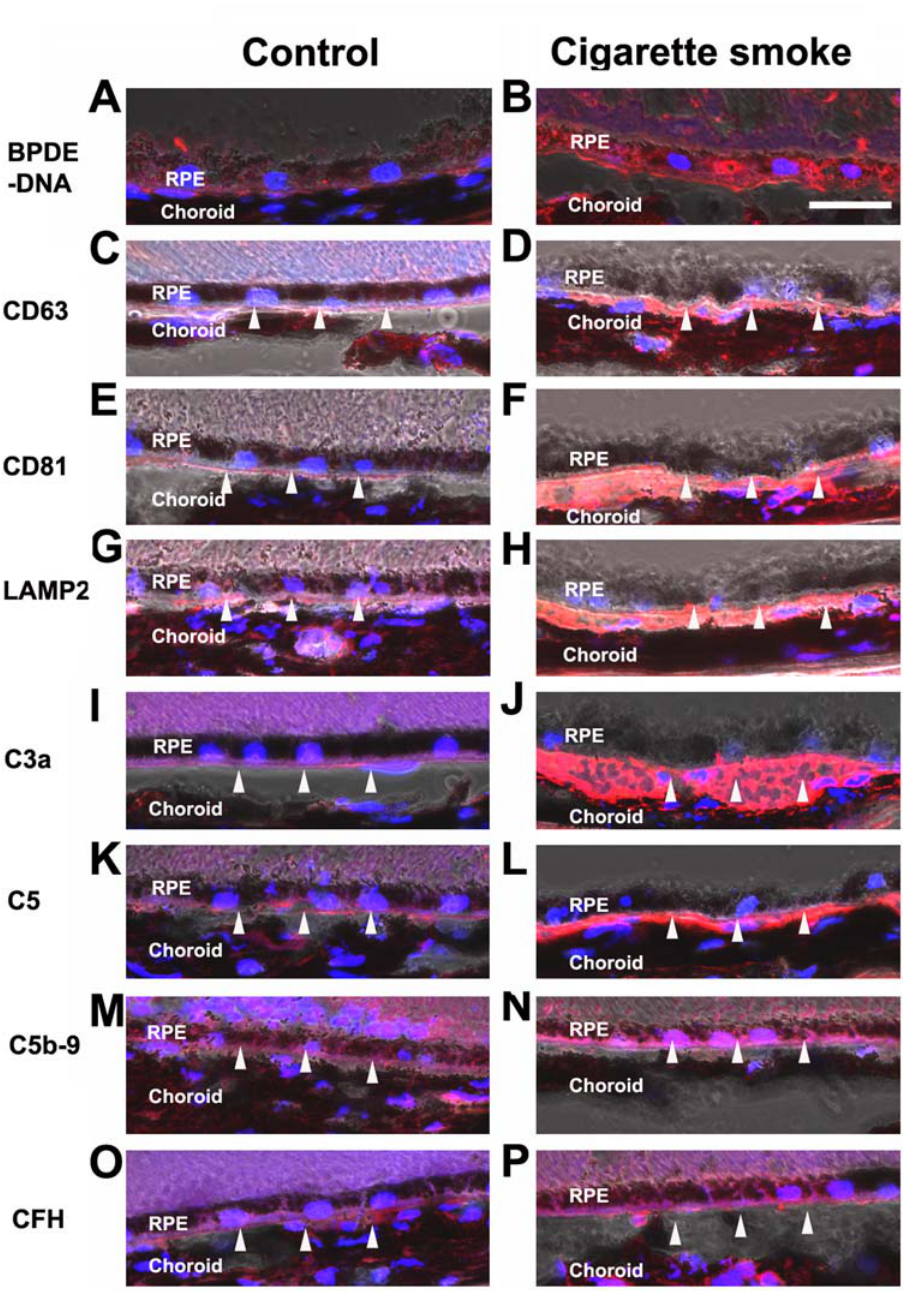
Figure 6. Immunolocalization of BPDE-DNA, exosome markers and complement pathway components in mice exposed to chronic cigarette smoke. These confocal immunofluorescence images were overlayed with the bright field images. (A–B) BPDE-DNA. Immunoreactivity to the BPDE-DNA adduct is present in RPE of mice exposed to chronic cigarette smoke ( B ), but not in control tissues ( A ). ( C–D ) CD63, Immunoreactivity to CD63 is observed in the area of Bruch’s membrane of mice exposed to chronic cigarette smoke ( D ), but not in the control tissues ( C ). ( E–F ): CD81. Immunoreactivity to CD81 is observed in the area of Bruch’s membrane of mice exposed to chronic cigarette smoke ( F ), but not in the control tissues ( E ). ( G–H ) LAMP2. Immunoreactivity to LAMP2 is observed in the area of Bruch’s membrane of mice exposed to chronic cigarette smoke ( H ), but not in the control tissues ( G ). ( I–J ) C3a. Immunoreactivity to C3a is observed in the area of Bruch’s membrane of mice exposed to chronic cigarette smoke ( J ), but not in the control tissues ( I ). ( K–L ) C5. Immunoreactivity to C5 is observed in the area of Bruch’s membrane of mice exposed to chronic cigarette smoke ( L ), but not in the control tissues ( K ). ( M–N ) Immunoreactivity to C5b-9 is observed in the area of Bruch’s membrane of mice exposed to chronic cigarette smoke ( N ), but not in the control tissues ( M ). ( O–P ) Immunoreactivity to CFH is observed in the area of Bruch’s membrane of mice exposed to chronic cigarette smoke ( P ), but not in the control tissues ( O ). Scale bar=20 m m. Blue: DAPI.